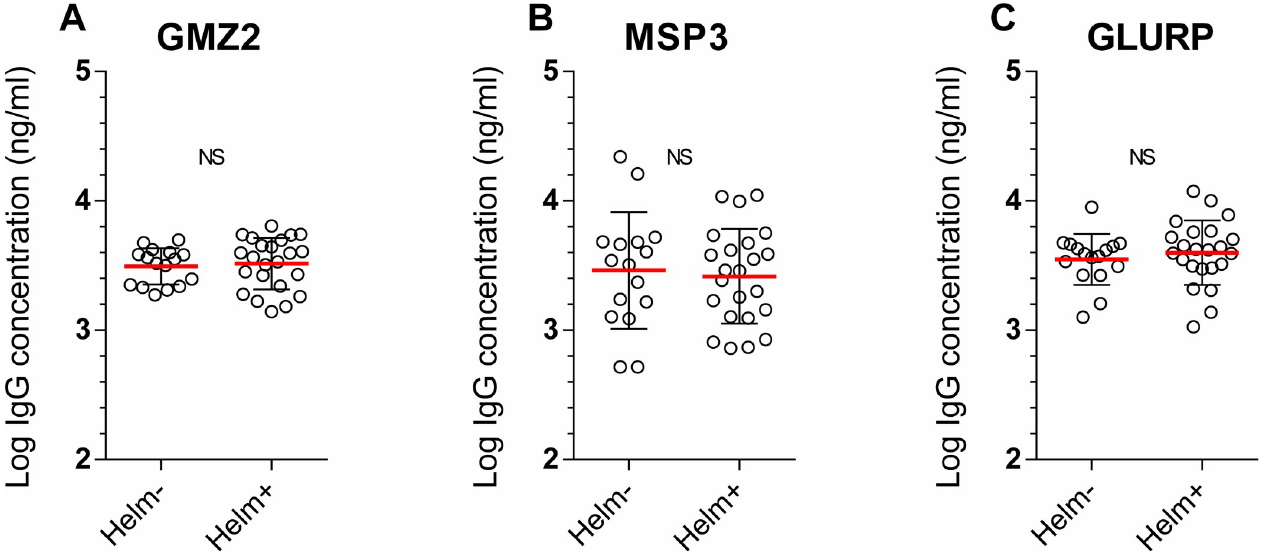
Fig 2. Post immunization antibody concentration at D84 in helminth uninfected and infected groups (Helm- and Helm+). Fig 2 illustrates the log of GMZ2-specific (A), MSP3-specific (B), GLURP-specific (C) IgG concentration at D84 in helminth negative (Helm-, n = 16) and helminth positive (Helm+, n = 23) groups. Comparisons were performed by univariate and multivariate linear regression adjusted for baseline data as independent covariable. The graphs are mean ± standard deviation. Statistical significance was set for p value below 0.05. � p < 0.05, �� p < 0.01, ��� p < 0.001, ���� p < 0.0001. NS =